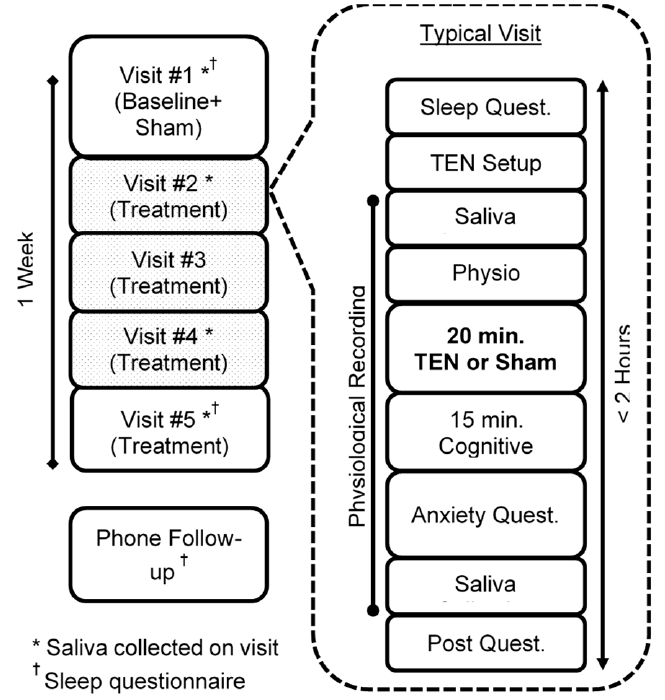
Figure 2. Study design.